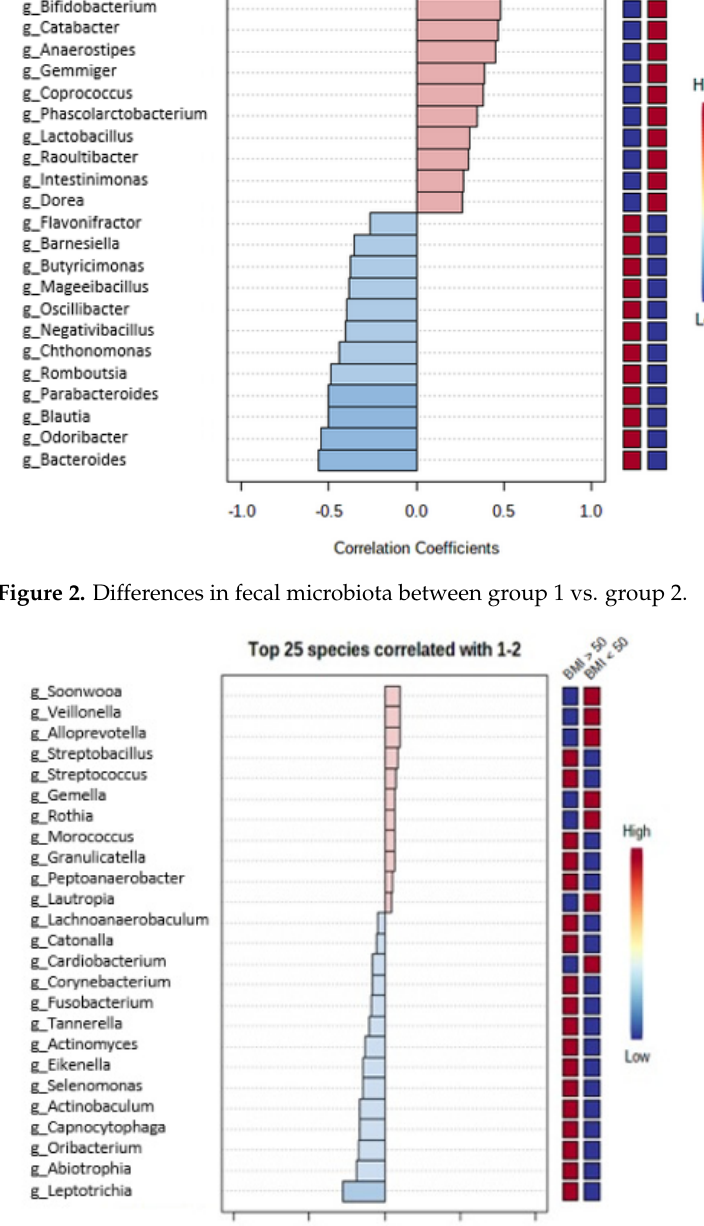
Figure 3. Differences in oral microbiota between the patients with BMI above 50 kg/m 2 vs. the other patients with obesity.